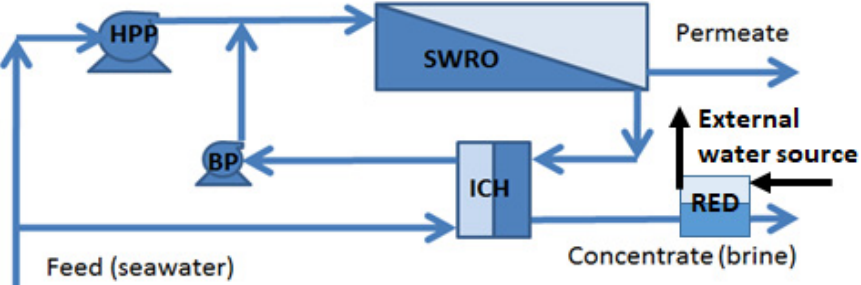
Figure 7. Conceptual diagram of coupling SWRO and RED systems. HPP: high pressure pump. BP: booster pump. ICH: energy recovery device based on isobaric chamber. SWRO: membrane